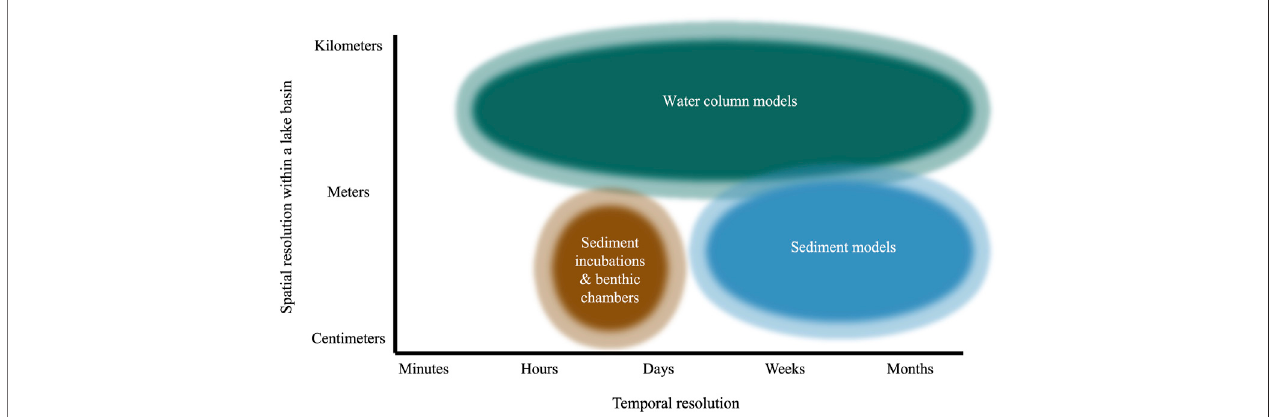
FIGURE 3 | Conceptual map showing the typical temporal and spatial resolution of common methodologies included in Figure 1 . Temporal resolution represents the typical time period over which measurements from each methodare made or averaged over. Spatial resolution indicates the spatial scale over which measurements from each method are made or averaged across within an individual lake